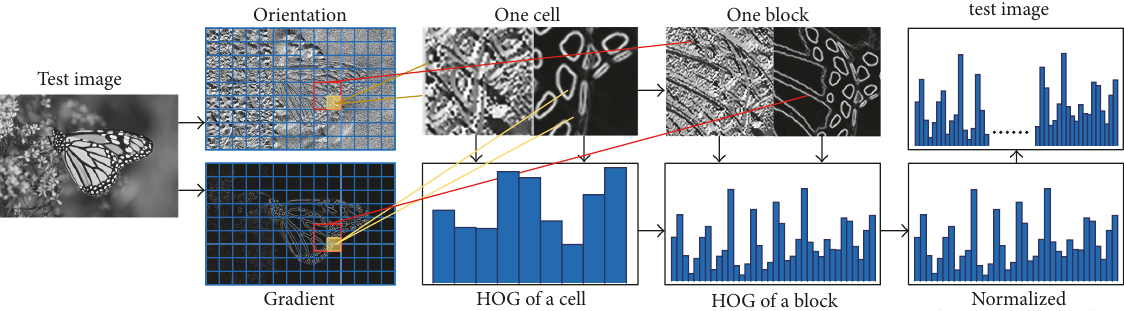
Figure 3: Illustration of HOG